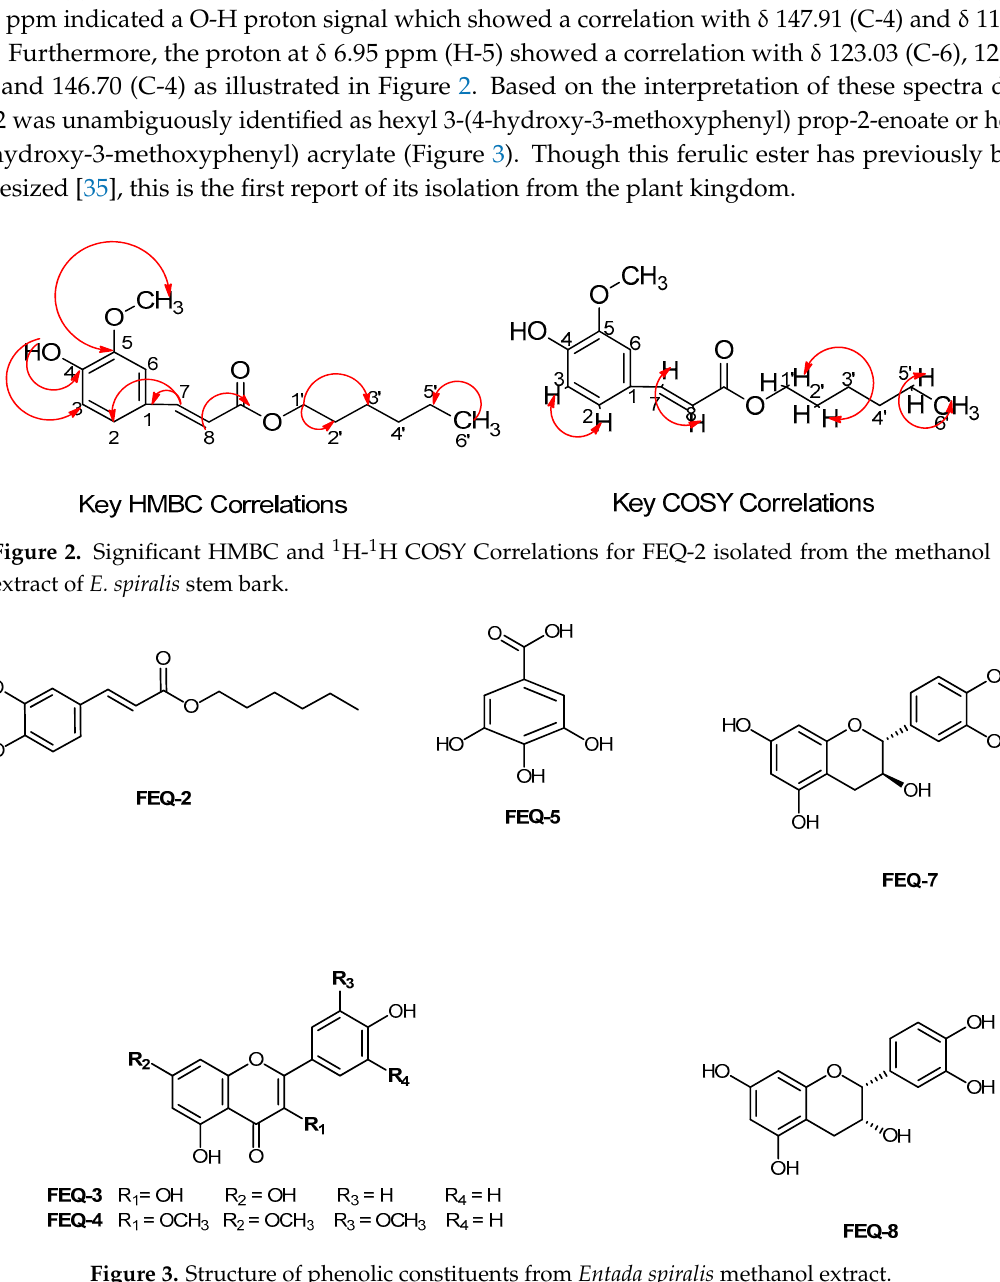
Table 6. 1 H, 13 C-NMR chemical Shifts (ppm) of the four aglycone flavonoids isolated from E. spiralis methanol extract.